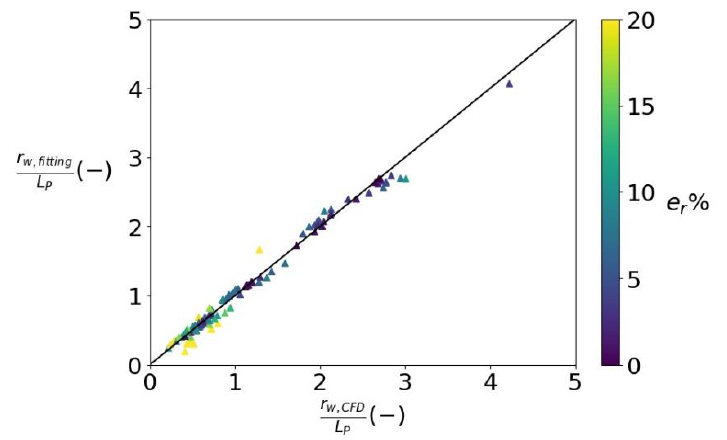
Figure 15. Comparison between the wetting radius computed using CFD simulations and fitting.